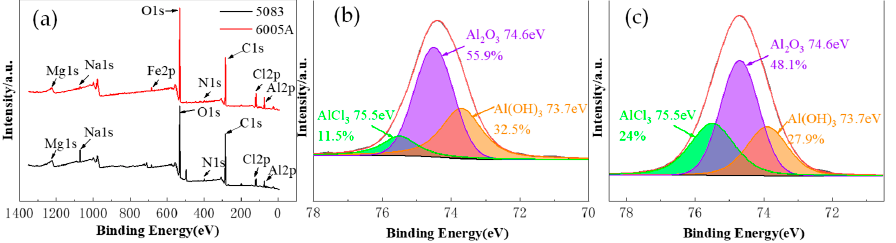
Figure 9. XPS spectra of the 5083/6005A welded joints corroded in the 3.5% NaCl + 0.01 mol/L NaHSO 3 solution for 7 days: ( a ) 5083 and 6005A survey spectra; ( b ) 5083 Al2p spectrum; ( c) 6005A Al2p spectrum.